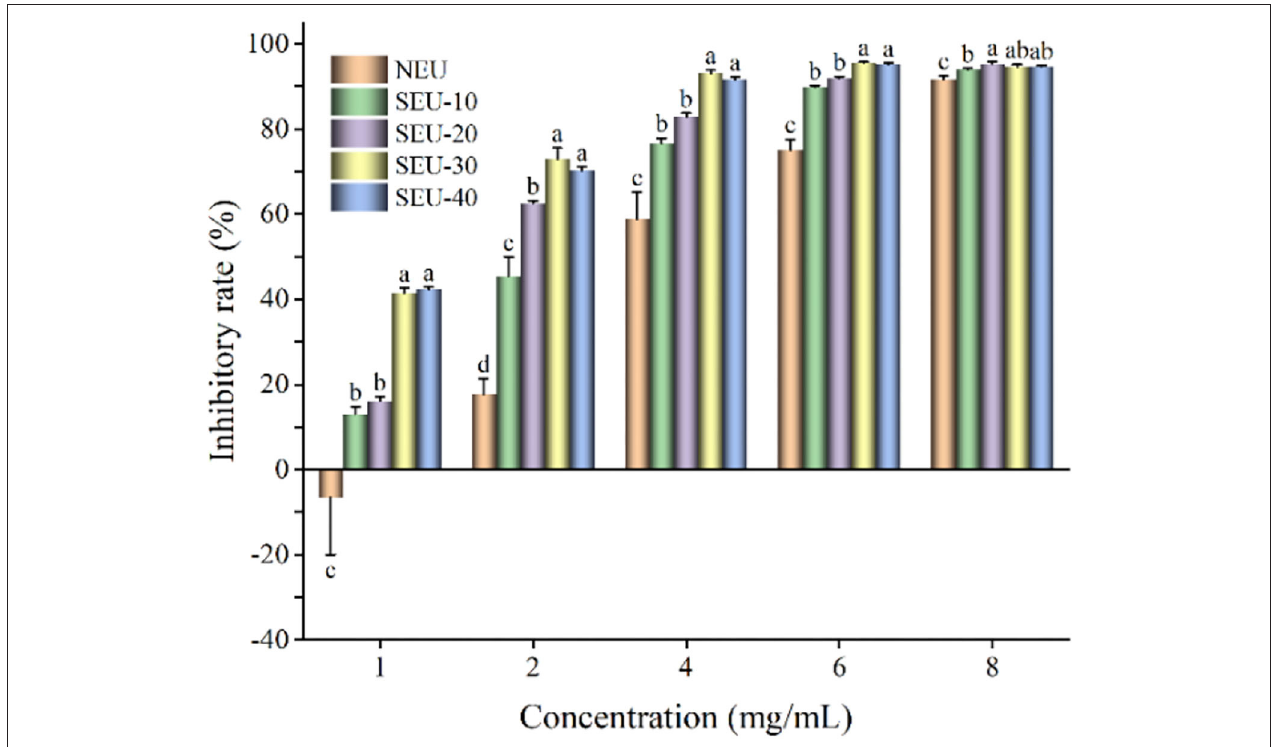
FIGURE 5 | Inhibitory rate of Eucommia ulmoides Oliver bark extract on HepG2 cells. NEU, native Eucommia ulmoides Oliver bark; SEU, steam-exploded Eucommia ulmoides Oliver bark, SEU(10) to SEU(40) indicated steam explosion retention time was 10–40min, respectively. (Means that do not share a letter are significantly different, p < 0.05). Different letters in the same concentration indicate significant differences at p < 0.05 as determined by Duncan’s multiple range test.